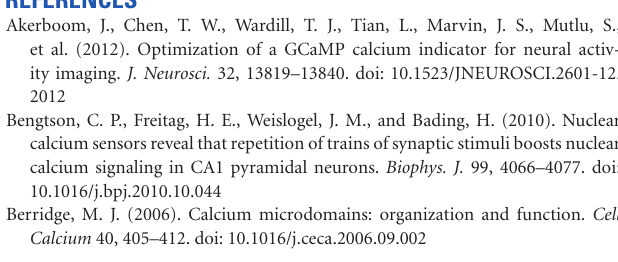
FIGURE 3 | Directed expression of genetically encoded calcium sensors to detect G q / 11 -GPCR activation. (A) Mating a “ driver ” mouse directed to express cre in a selective dopamine D2 ( drd2 ) fashion to a cre-dependent “ reporter ” GCaMP 3 mouse yields offspring which may inherit the driver-reporter combination of genes ( green offspring). The offspring which do not inherit this combination will not express the calcium detector ( non-fluorescent offspring). (B) Illustrates a confocal image of a coronal mouse brain section from an animal inheriting the drd2 ; cre and rosa26 ; GCaMP3 genes, permitting fluorescent detection of calcium changes in striatal